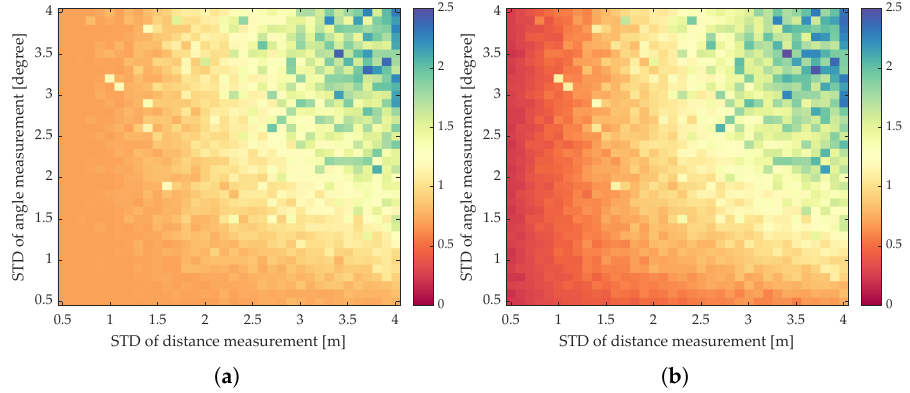
Figure 8. RMSE of localization versus STD of the measurement: ( a ) grid-based results; ( b ) NLS- based